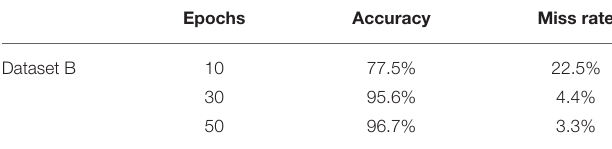
TABLE 6 | Training model on dataset B.